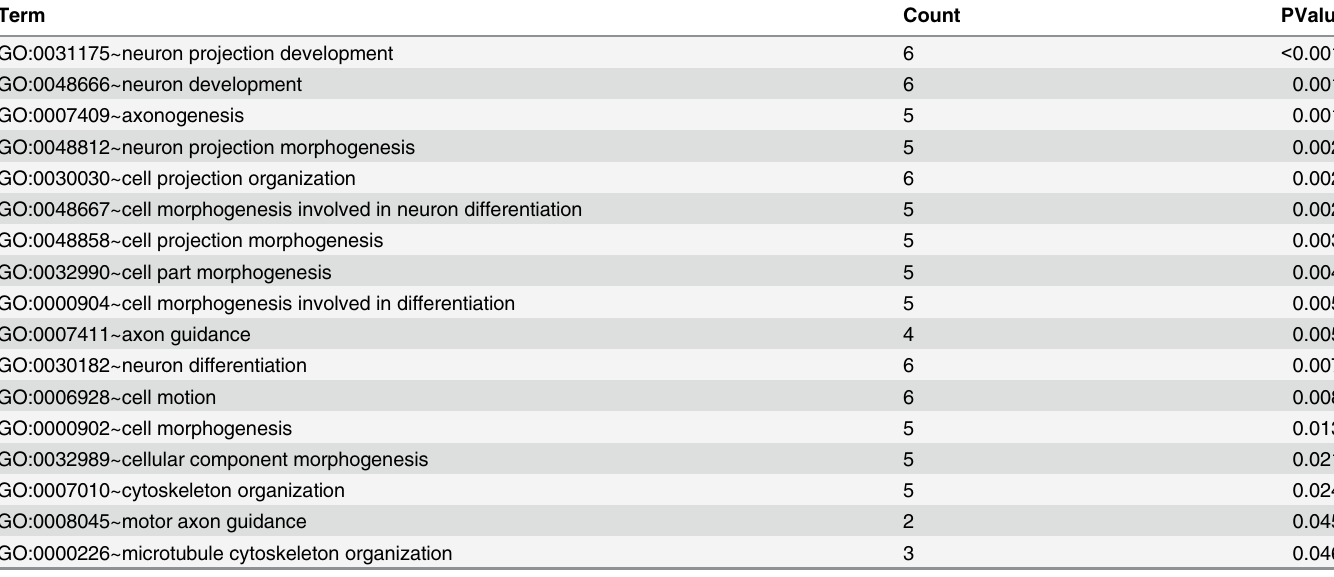
The table shows the GO-term assigned by the software DAVID, the number of genes in the category (Count) and the P-value (adjusted for false discovery rate) for the enrichment of the